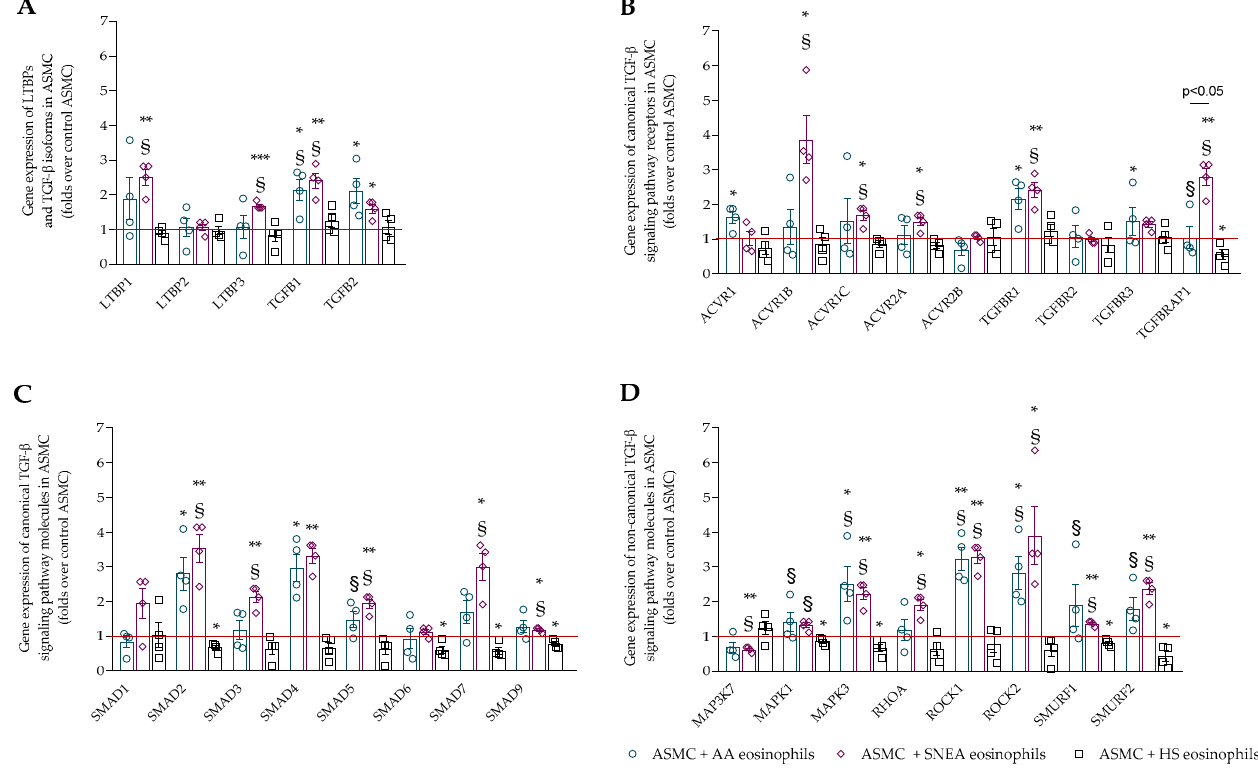
Figure 4. ( A )—Gene expression of LTBPs and TGF- β isoforms in ASMC; ( B )—Gene expression of canonical TGF- β signaling pathway receptors in ASMC; ( C )—Gene expression of canonical TGF- β signaling pathway molecules in ASMC; ( D )—Gene expression of non-canonical TGF- β signaling pathway molecules in ASMC. AA—allergic asthma; HS—healthy subjects; SNEA—severe non-allergic eosinophilic asthma. AA, n = 4, SNEA, n = 4, HS, n = 4. Data are presented as mean ± SEM, fold change over control ASMC. * p <0.05 compared with control ASMC; ** p < 0.01 compared with control ASMC; *** p < 0.001 compared with control ASMC; § p < 0.05 compared with HS eosinophil effect. Statistical analysis between investigated groups—two-sided Mann–Whitney U test (independent data); two-sided Wilcoxon matched-pairs signed-rank test (dependent data); and Wilcoxon signed-rank test, which was used for gene expression analysis against control ASMC that were not incubated with eosinophils.